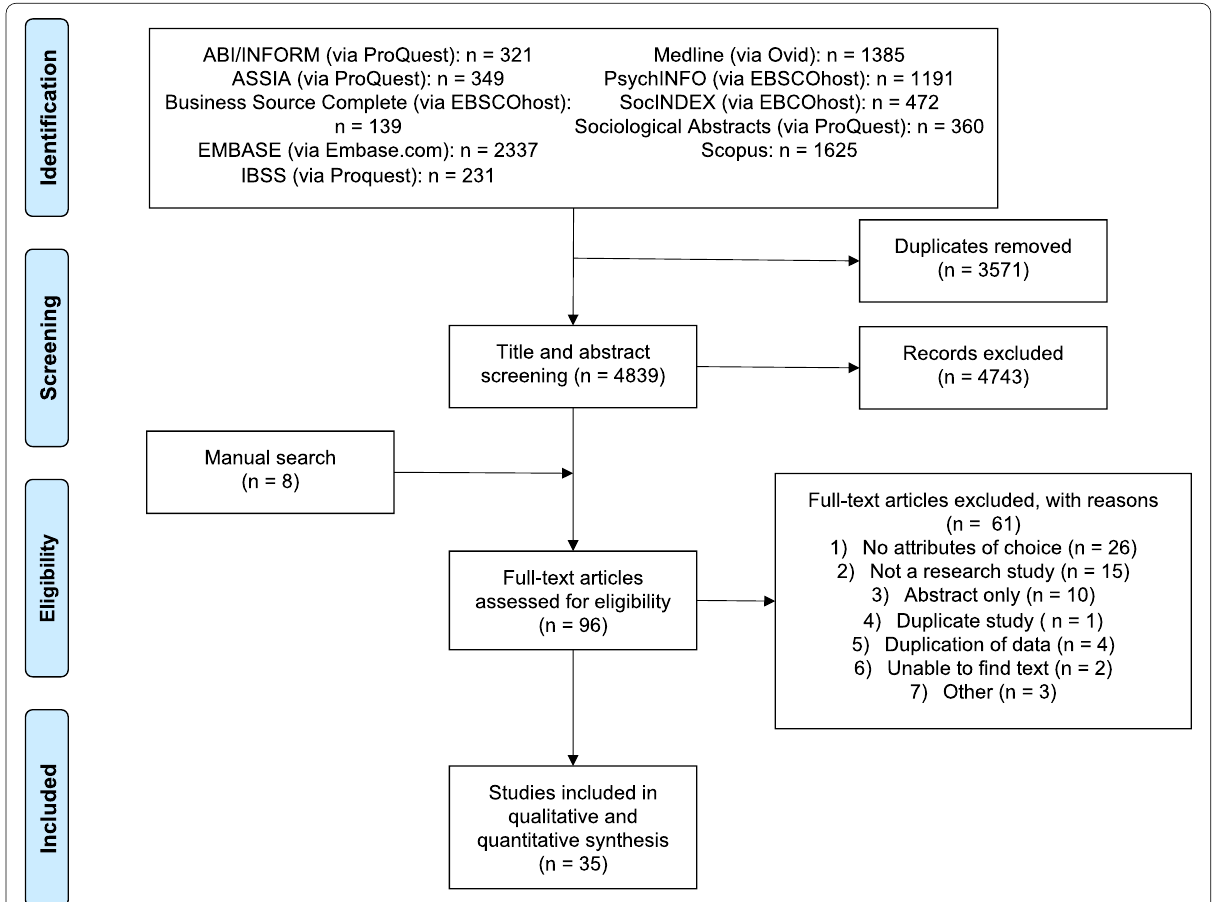
Fig. 1 PRSIMA flow diagram of studies’ screening and